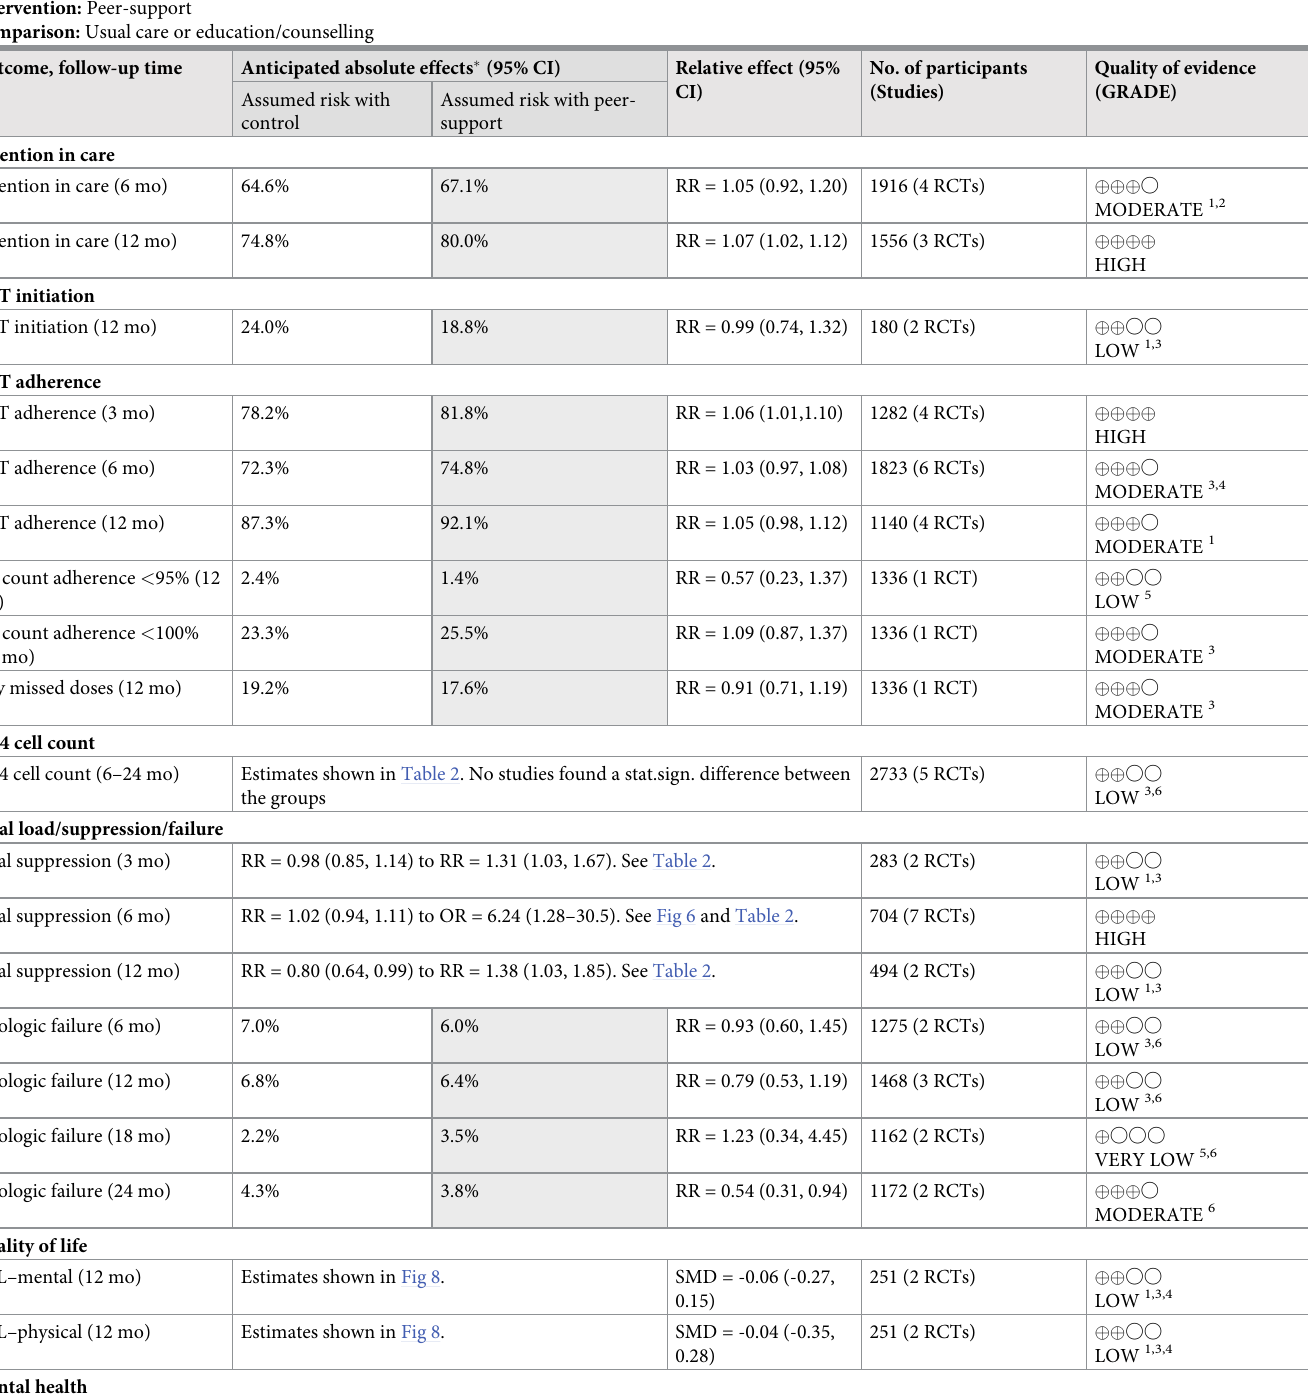
Table 3. Certainty of evidence of effect of peer-support for people living with HIV. Population: People living with HIV Countries: China, Kenya, Mozambique, Nigeria, Spain, Uganda, USA,